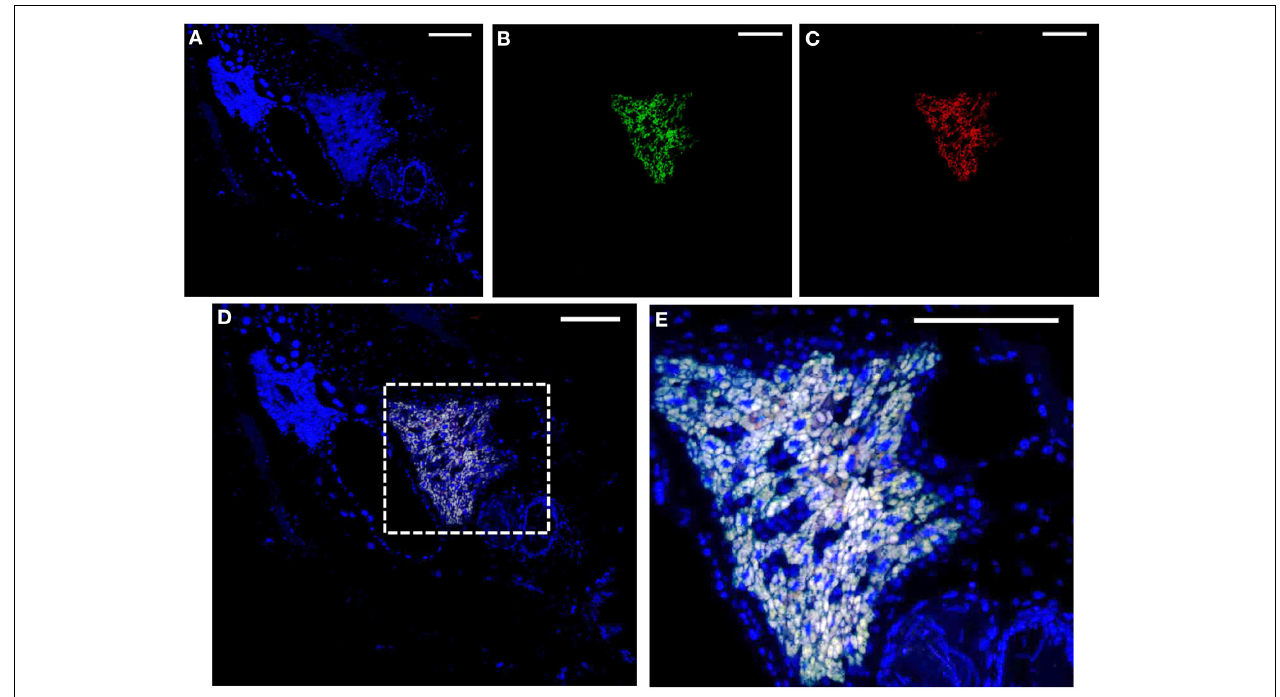
FIGURE 4 | FISH analysis of P. peruvianus bacteriome. Adult female mealybugs stained with DAPI (blue: A,D,E ) and probed with Cy5-EUB338 (green: B,D,E ) and Cy3-TphPPER1290 (red: C–E ). (A–D) Complete insect